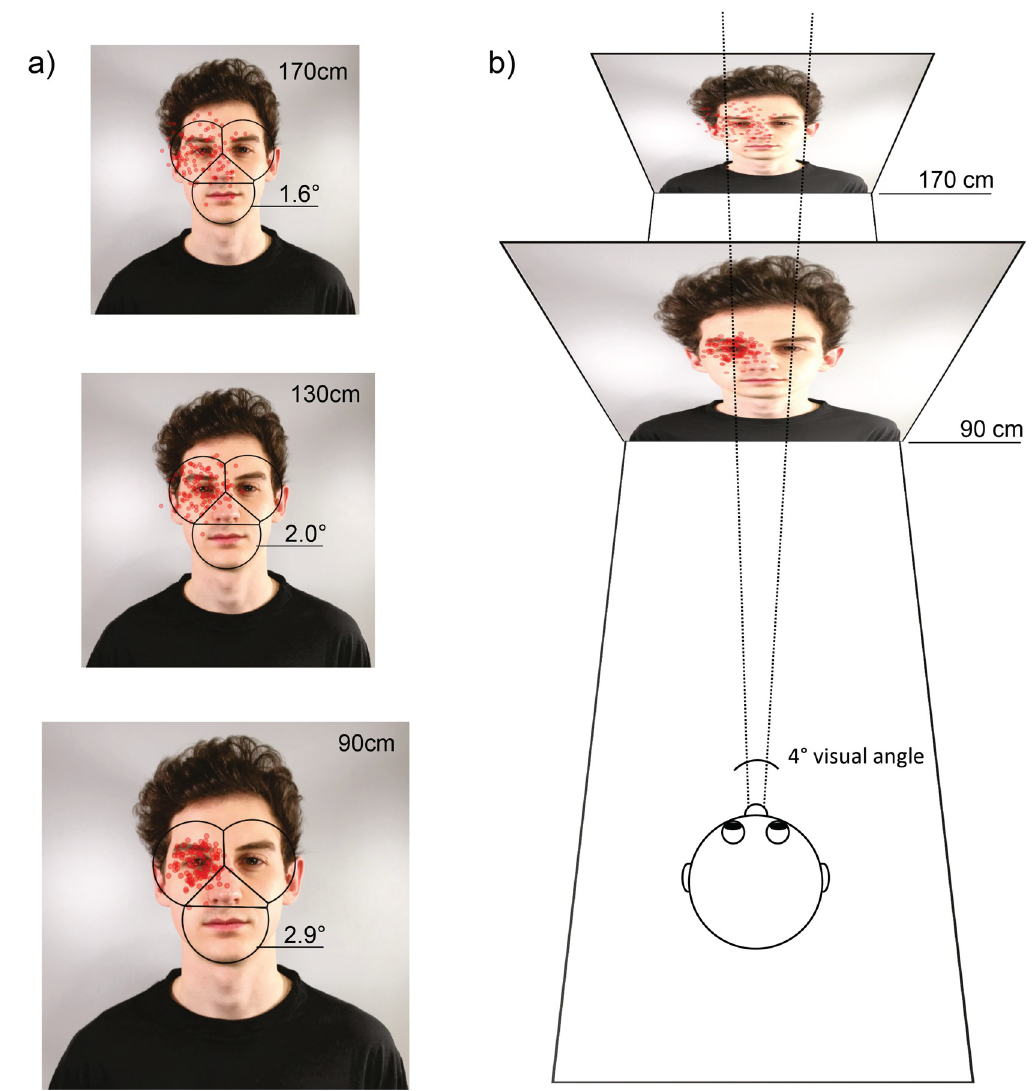
Fig 5. Effect of viewing distance on stimulus size and fixation point deviation. (A) Visualization of the stimulus size over three viewing distances (90cm, 130cm & 170cm) with AOIs covering the same facial areas (radius 4.6cm; in visual degree angle: 1.6˚, 2.0˚ & 2.9˚) and simulated fixation points on the left eye. (B) Visualization of the interaction between visual angle and viewing distance on fixation point deviation. In both figures (A & B) each red dot represents the averaged fixation location of 30 simulated fixations with an accuracy of 1.5˚; a total of n = 100 data set were simulated. The stimulus shown in A and B was created for illustrative purposes only and is not part of the stimulus set used in the study (see Methods